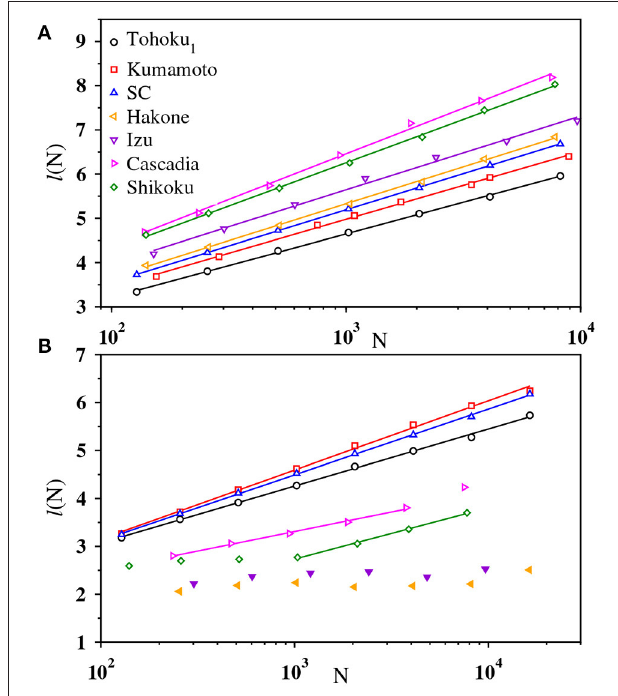
FIGURE 11 | The plots exhibit small-world behavior of the visibility graph for (A) magnitude and (B) IET time series of Tohoku 1 (black), Kumamoto (red), Southern California (blue), Hakone (solid orange), Izu (solid violet), Cascadia (magenta), and Shikoku (green). For visual clarity data of l ( N ) have been shifted vertically. Multiplicative factors in the upper panel are 1, 1.05, 1.10, 1.15, 1.20, 1.25, and 1.30, respectively. In the lower panel [the labels are same as in (A) ] y / data for swarms have been shifted as y =